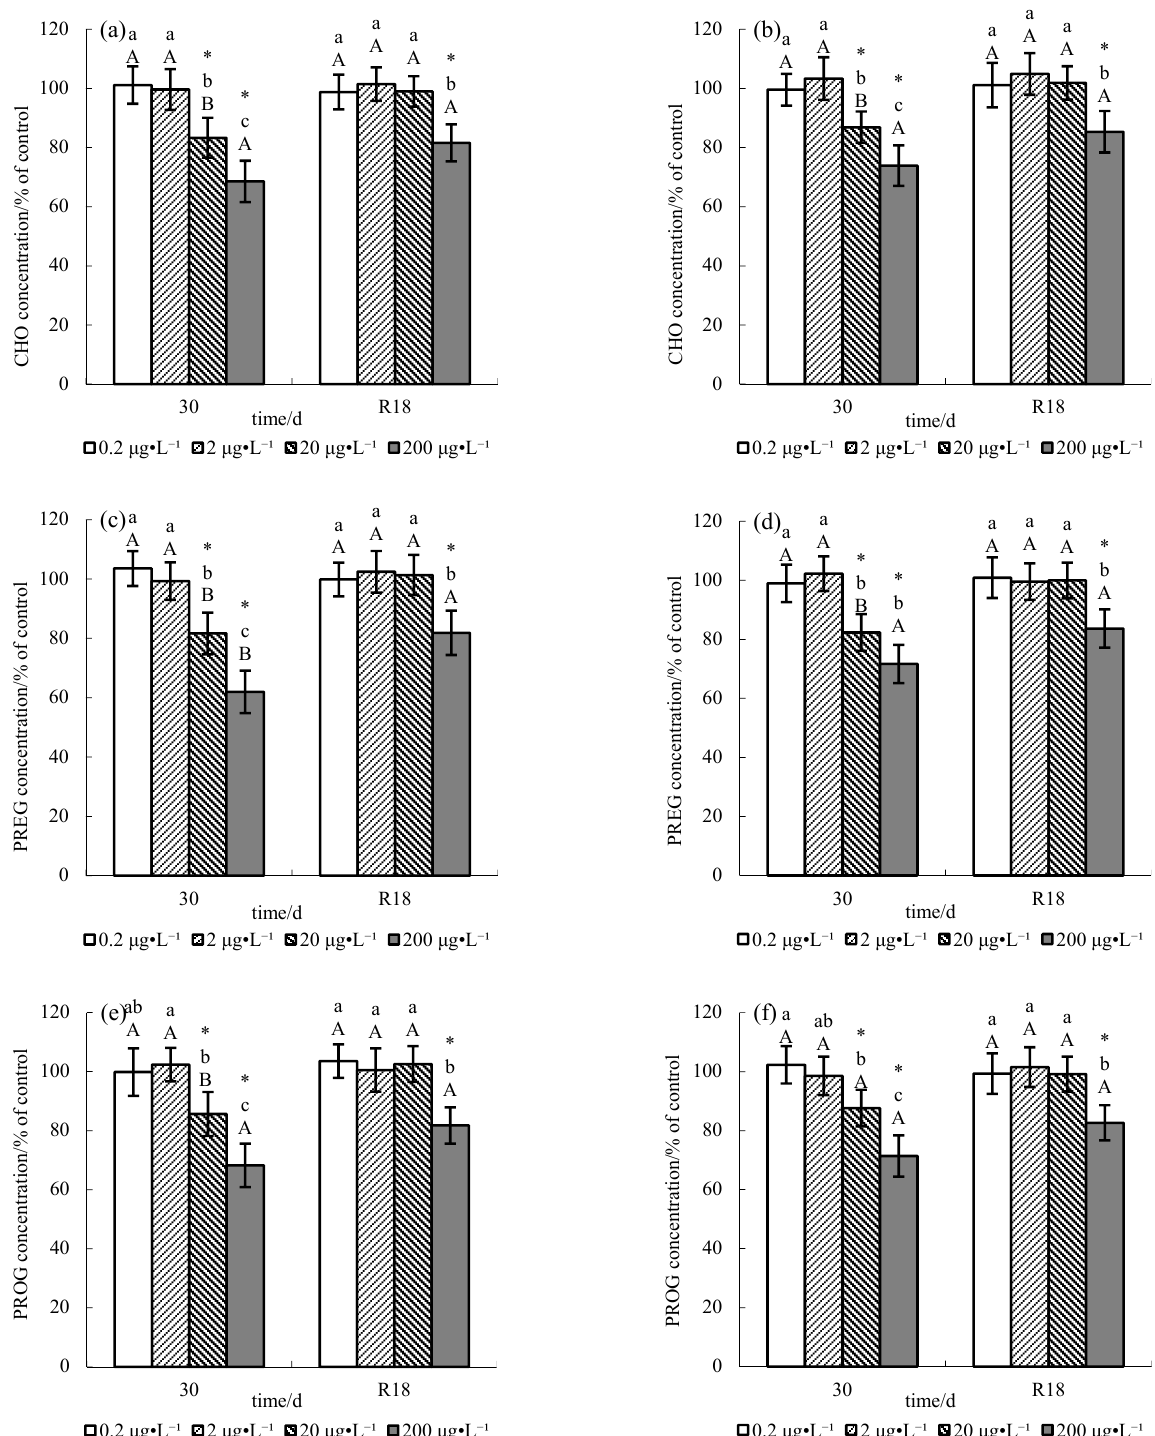
Figure 1. Cholesterol (CHO), pregnenolone (PREG), and progesterone (PROG) levels in testes ( a , c , e ) and serum ( b , d , f ) of male O. niloticus exposed to methomyl for 30 days and after an 18-day recovery period in methomyl-free water (R18). (Note: All the data were expressed as Average ± SD ( n = 6). “*” means significant difference from the control. Different lower-case letters indicate significant difference among concentrations at the same exposure period, and different upper-case letters indicate difference between exposure and recovery periods at the same methomyl concentration, with p < 0.05 considered significant).